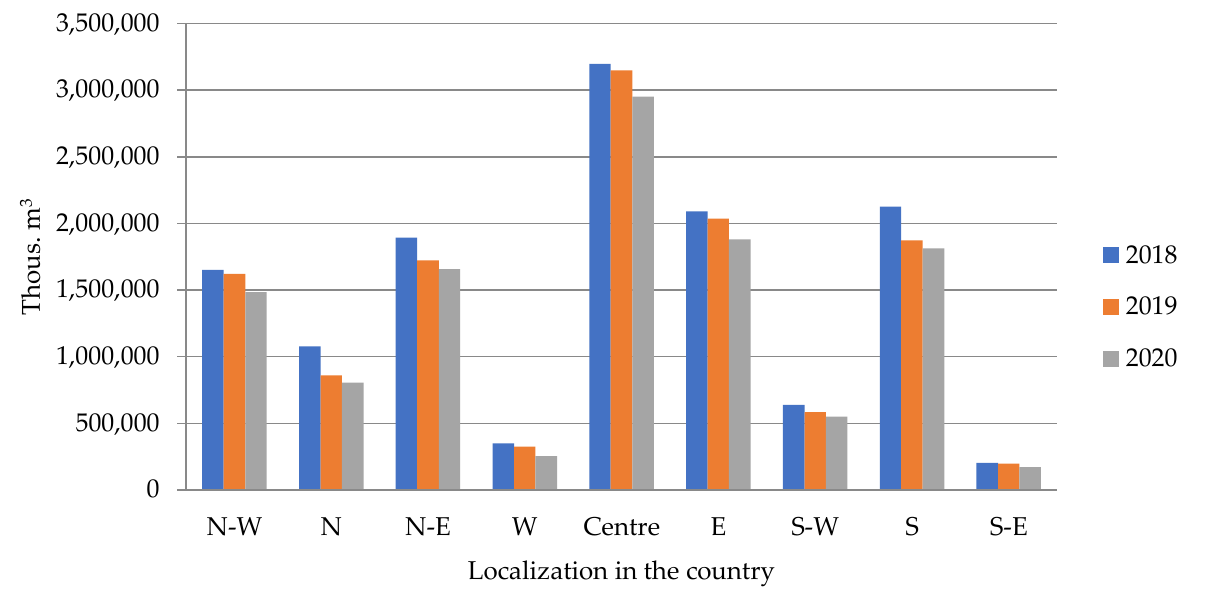
Figure 11. A comparison of the potential of wood biomass harvested in forests and sawmills in Poland. Own elaboration based on the available data.